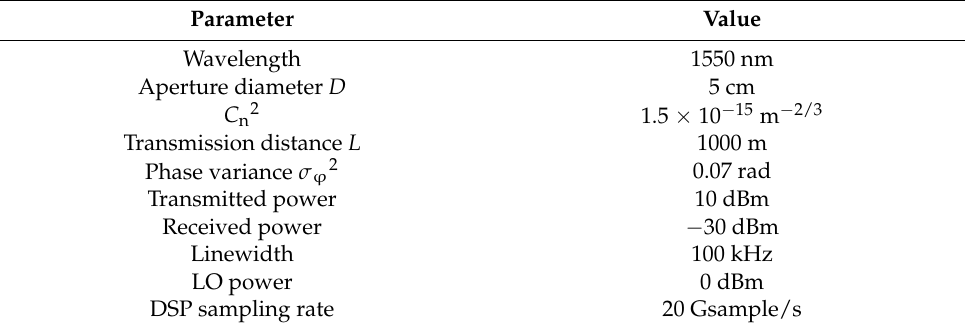
Table 2. Parameters used in the numerical